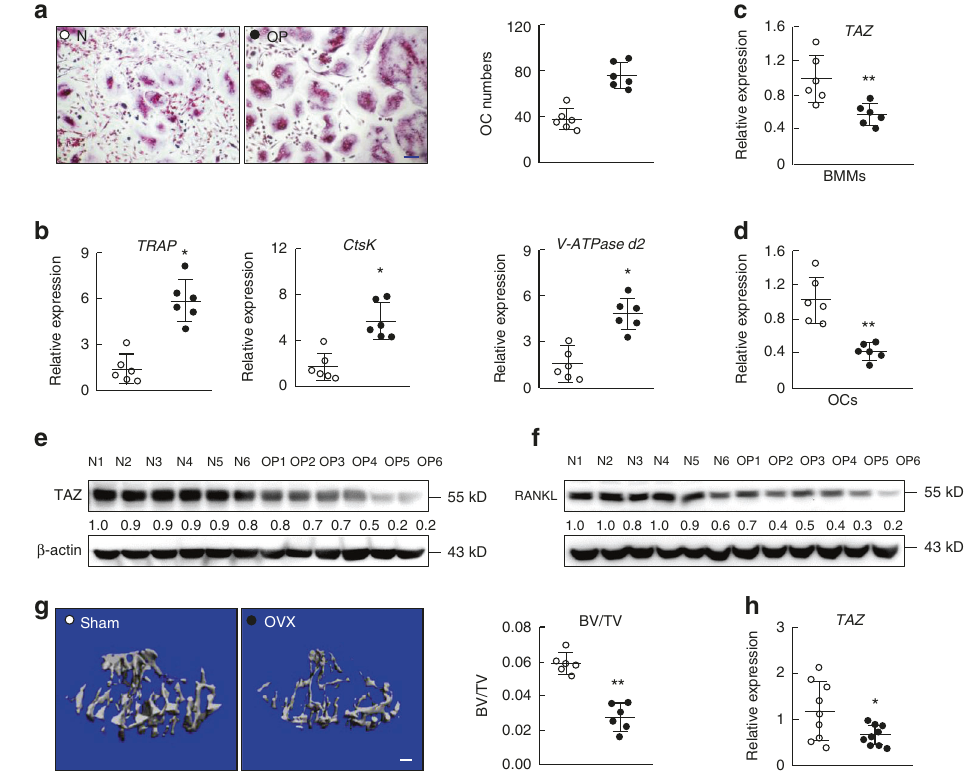
Fig. 1 The expression of TAZ is downregulated in osteoporosis. a TRAP-staining and quantitation of multinucleated osteoclasts derived from BMMs from normal bone density (N, control group, underwent posterior internal fi xation following thoracolumbar fracture) and osteoporotic (OP, underwent percutaneous kyphoplasty following thoracolumbar fracture) animals stimulated with 100 ng·mL − 1 RANKL for 10 d. Scale bar denotes 10 μ m. b Real-time qPCR analysis of the expression of osteoclast marker genes. Real-time qPCR analysis of the expression of the TAZ gene in BMMs ( c ) and osteoclasts ( d ) from the N and OP groups, respectively; n = 6. e and f Western blot analysis of the TAZ protein from BMMs and osteoclasts from the N and OP groups, respectively. g Three-dimensional micro-CT reconstructions of tibias from the sham (control) and ovariectomy (OVX) group. Scale bar denotes 200 µm. h Real-time qPCR analysis of the expression of the TAZ gene. In a − f , ○ and ● represent the N and OP groups, respectively. In g and h , ○ and ● represent the sham and OVX groups, respectively. An unpaired Student ’ s t test was performed. * P < 0.05, ** P < 0.01. BMD, bone mineral density; BMM, bone marrow-derived during surgery were examined. Patient information is tabulated in RESULTS Supplementary Table 2. Three-dimensional (3D) reconstructions of TAZ is downregulated in osteoporosis micro-computed tomography (CT) scans and quantitative morpho- To determine the relationship between TAZ expression and metric analyses of the OA and OP femoral heads were performed osteoclasts in human osteoporosis, bone marrow specimens were (Supplementary Fig. 2a). Histological and quantitative histomorpho- collected from the thoracolumbar vertebrae in patients with metric analyses (Supplementary Fig. 2b), as well as the determina- thoracolumbar vertebral fractures with or without osteoporosis. tion of bone mineral density (BMD) by dual-energy X-ray Patient information is tabulated in Supplementary Table 1. In the absorptiometry (Supplementary Fig. 2c), further con fi rmed the OP group, bone marrow was harvested during percutaneous lower bone mass trend in the OP femoral heads. Furthermore, we kyphoplasty procedures for osteoporotic vertebral compression assessed the serum level of the bone resorption marker C-terminal fracture. In the control group, bone marrow was harvested during telopeptide of type 1 collagen (CTX), which was reportedly higher in posterior internal fi xation for thoracolumbar burst fracture in the OP group than in the OA group (Supplementary Fig. 2d). patients without osteoporosis. The bone marrow was cultured to Consistent with the higher bone loss in the OP group, the obtain bone marrow-derived macrophages and osteoclasts. The expression of osteoclast marker genes, including tartrate-resistant results showed that osteoclast formation (Fig. 1a) and the acid phosphatase (TRAP) , cathepsin K (CTSK) , and V-ATPase subunit d2 expression of osteoclast marker genes (Fig. 1b) were higher in ( V-ATPase d2) , was markedly upregulated in the OP group compared the OP group than in the normal bone density control group. with the OA group (Supplementary Fig. 2f). The expression of Interestingly, the expression of the TAZ gene was downregulated in osteogenic marker genes, including runt-related transcription factor 2 BMMs and osteoclasts from the OP group compared with those (RUNX2) , alkaline phosphatase , and osteocalcin , was signi fi cantly from the control group (Fig. 1c, d). In addition, the expression of the downregulated in the OP group compared with the OA group TAZ protein in BMMs and osteoclasts derived from the OP group (Supplementary Fig. 2e). Interestingly, the expression of the TAZ was lower than that in BMMs and osteoclasts derived from the gene was downregulated in the OP group compared with the OA normal bone density control group (Fig. 1e, f). These results group (Supplementary Fig. 2g), suggesting that TAZ may play a role suggested that TAZ may play a role in osteolytic osteoporosis. in the pathogenesis of osteoporosis. To further support the existence of a relationship between TAZ In addition, lower TAZ expression in osteoporosis was also expression and human osteoporosis, osteoporotic (OP) and evidenced by the OVX mouse model. The results showed a lower osteoarthritic (OA, control group) femoral head specimens obtained